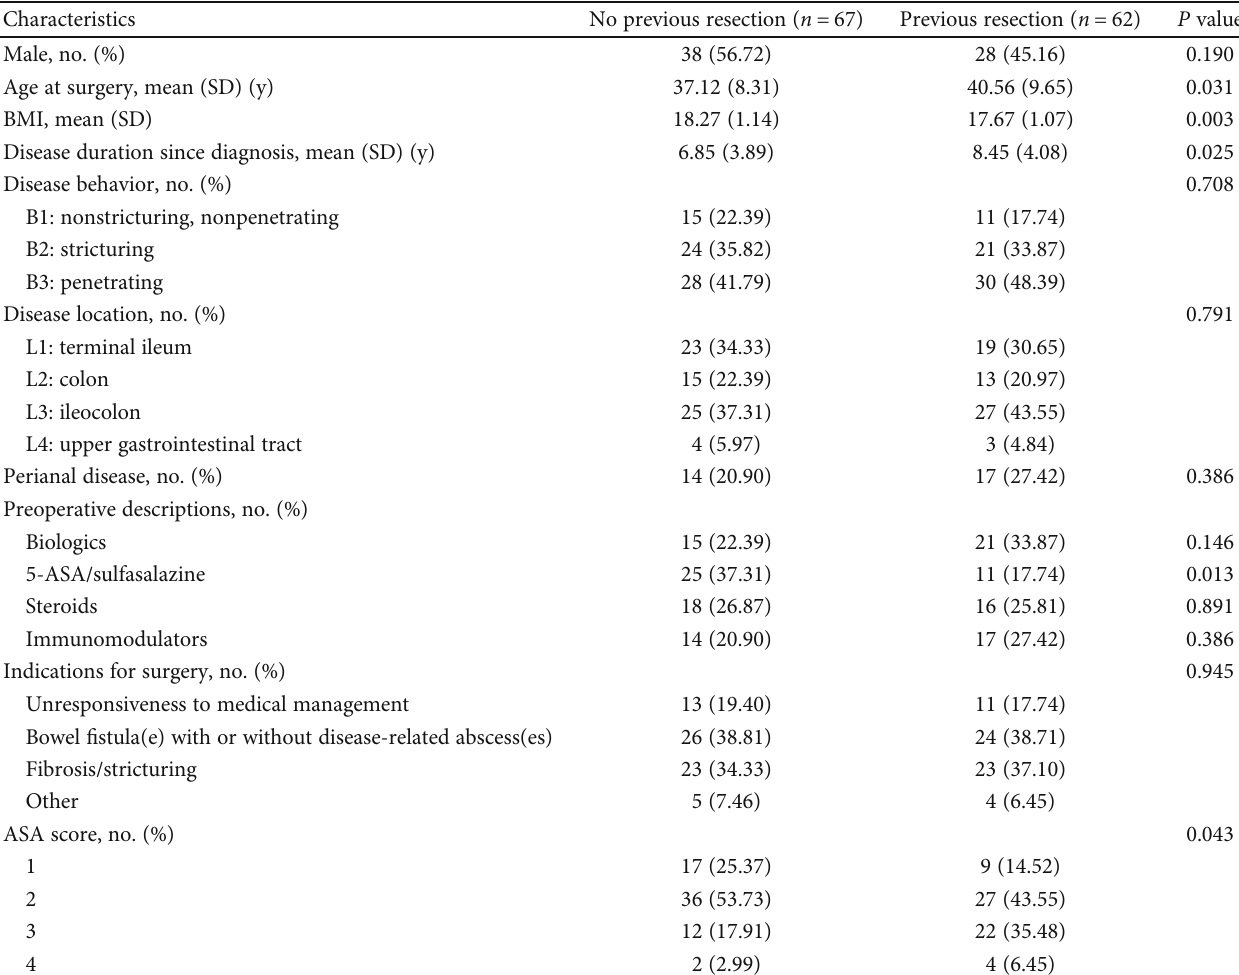
Table 1: Patient demographics and preoperative